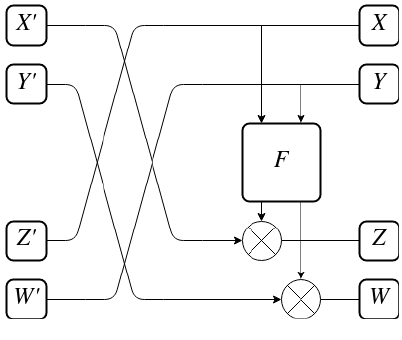
Figure 12. Inverse